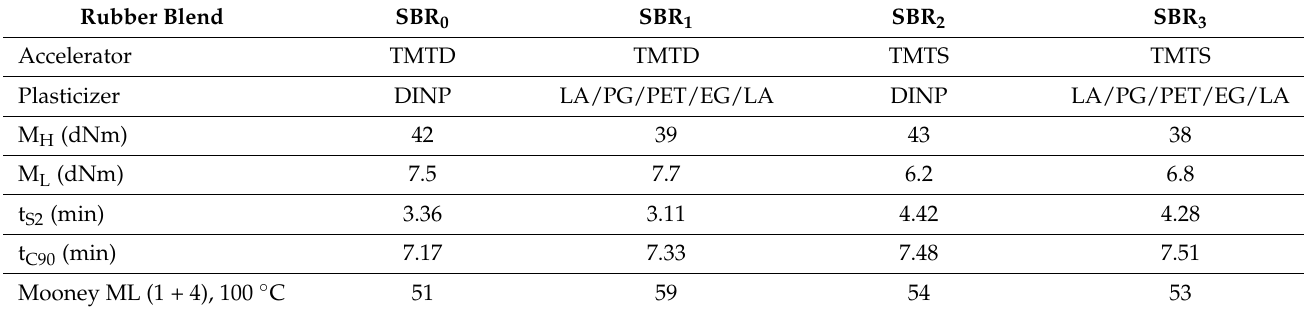
Table 9. The rheological properties of SBR after vulcanization at 170 ◦ C for 15